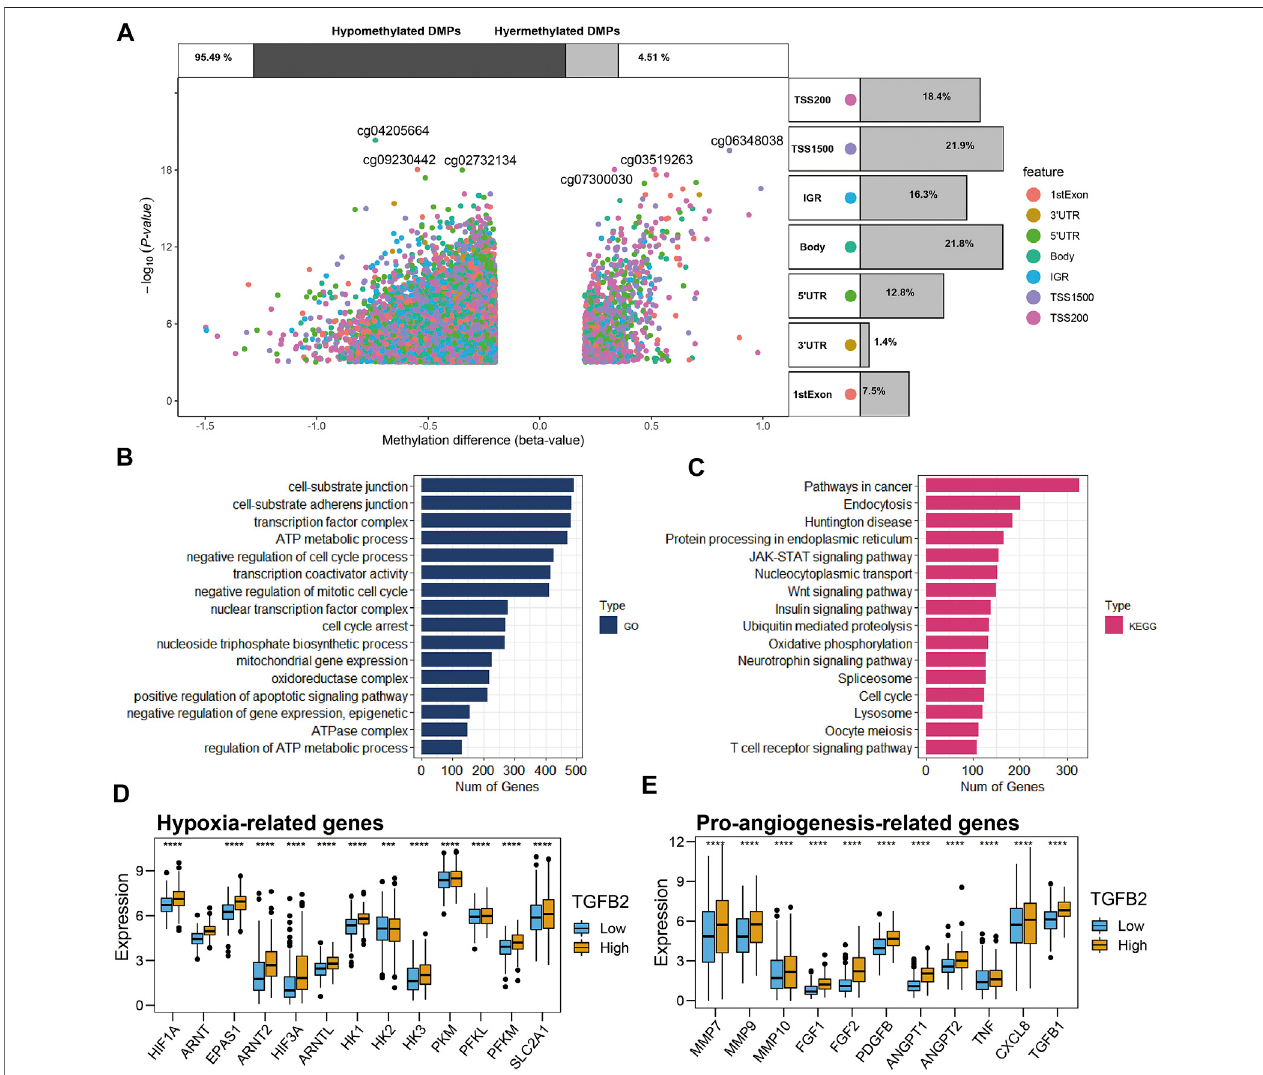
FIGURE 4 | Differential analysis of methylation and functional enrichment analysis. (A) Methylation volcano plots for different TGF β 2 methylation score groupings, with the location information of the methylation sites annotated on the right side of the fi gure notes and the expression differences of methylation on the top. (B,C) Methylation functionalenrichmentanalysis, GO and KEGG results. Comparison of hypoxia-related genes (D) and pro-angiogenesis-related genes (E) in different TGF β 2 subgroups. * p < 0.05, ** p < 0.01, *** p < 0.001, and **** p < 0.0001.